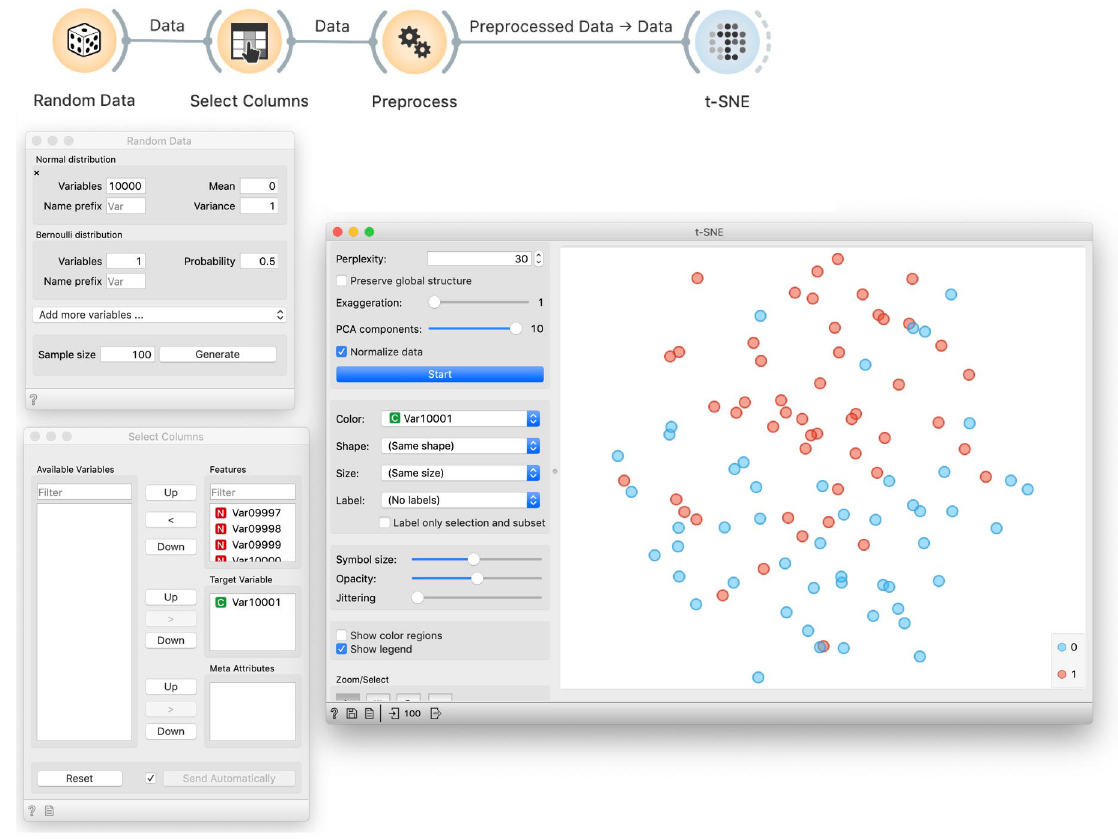
Fig 12. Colored t -SNE on random data. Data preprocessed by feature selection is visualized in a t -SNE plot that separates the data instances of different class, denoted by blue and red color. Density of blue data points is higher in the top part of the visualisation, and green points are denser at the lower half of the plot. This separation of instances of different class is seemingly surprising as the class value assignment is random, and is a by-product of preprocessing and choosing of ten features that are, albeit arbitrarily, most correlated with the class